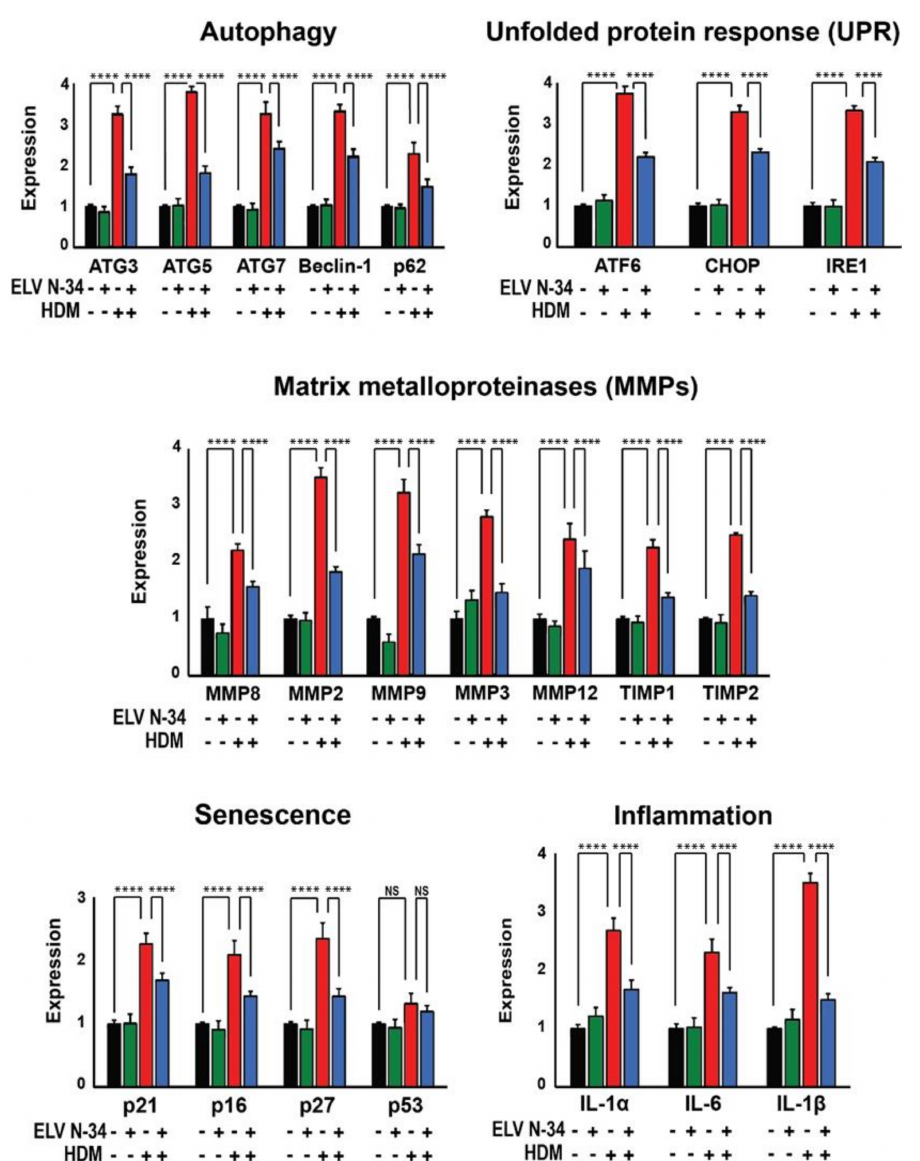
Figure 6. HDM triggered multiple signaling in HNEpC. HNEpC challenged with HDM ( D. farinae + D. pteronyssinus ) (30 µ g/mL) induces the expression of several genes related with autophagy (ATG3, ATG5, ATG7, BECLIN-1, and P62), unfolded protein response (UPR) (ATF6, CHOP, and IRE1), and matrix metalloproteinases (MMPs) (MMP8, MMP2, MMP9, MMP3, MMP12, TIMP1, and TIMP2). HDM stressors also induce the expression of senescence (P21, P16, P27, and P53) and inflammation genes (IL-1 α , IL-6, and IL-1 β ) on HNEpC. The treatment with ELVN-34 Na (500 nM) reduces the expression of autophagy, UPR, MMP, senescence (except P53), and inflammation genes induced by HDM extracts. The results showed the averages of three independent experiments. (**** p < 0.0001, NS—not